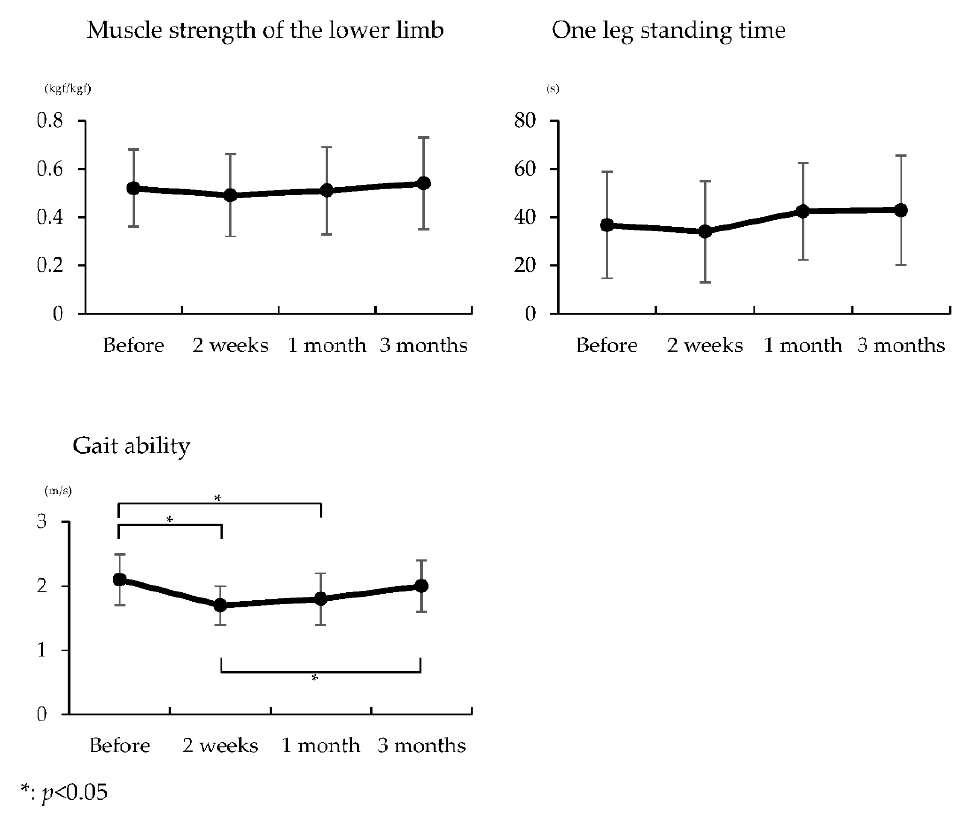
Figure 1. Comparisons of body composition, physical function, and gait ability at before, two weeks, one month, and three months after surgery.